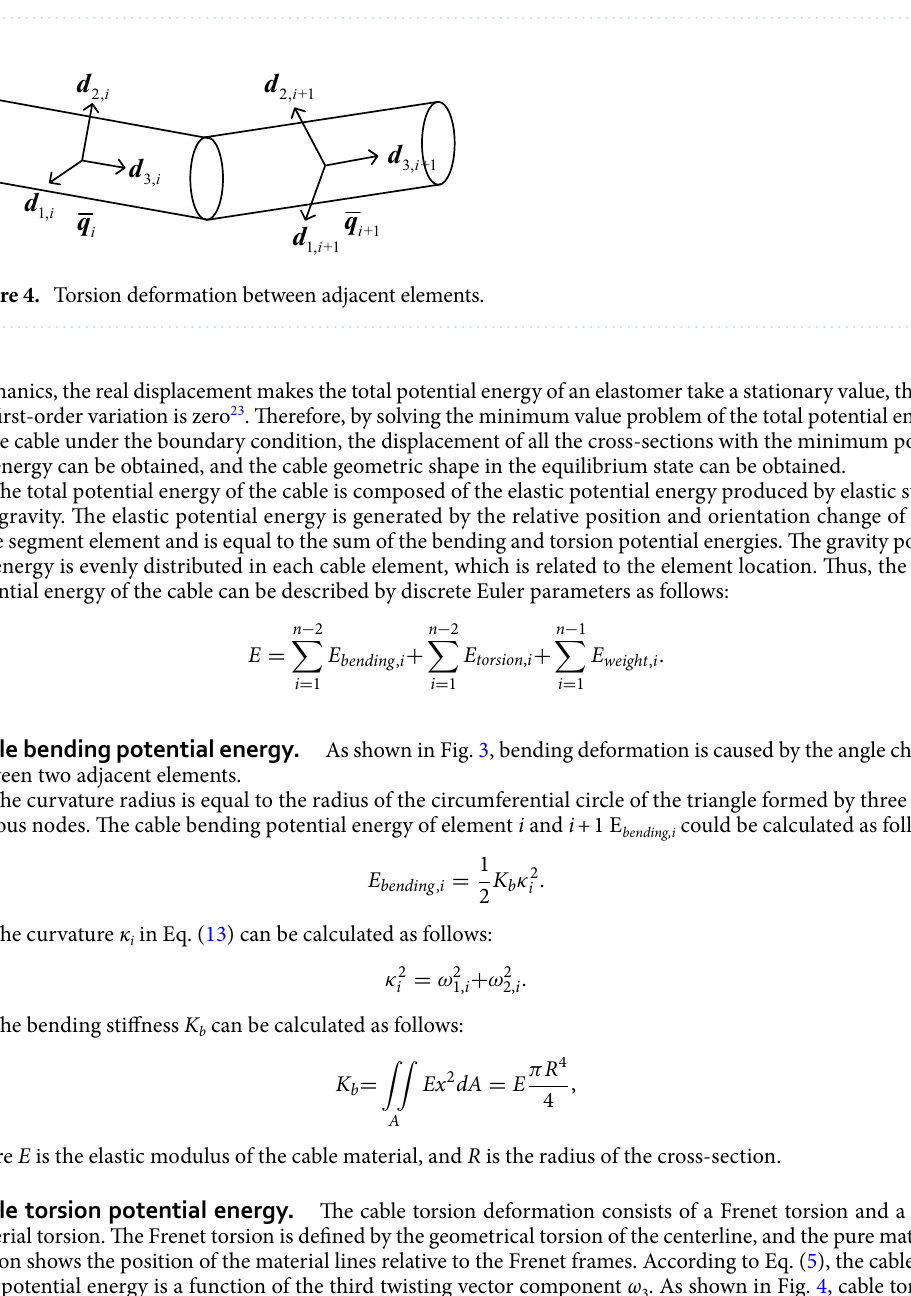
Figure 3. Bending deformation of adjacent elements.